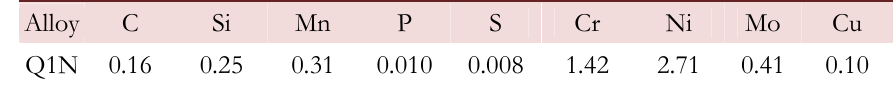
X- RAY DIFFRACTION EXPERIMENTAL